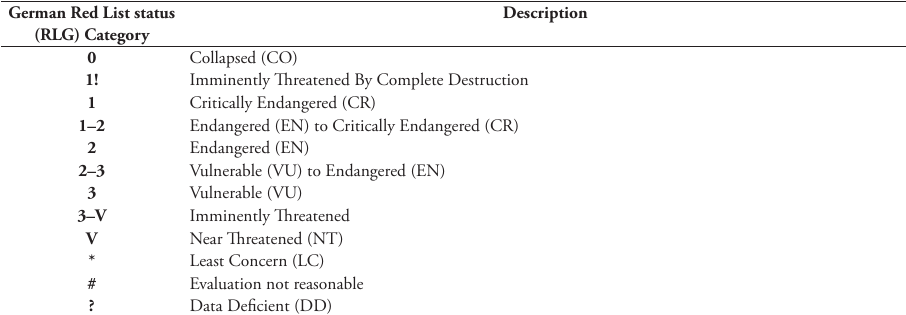
Table 4. Categories of the German Red List status (RLG). The (verbal-descriptive) definitions of the Red List categories are derived from the possible combinations of the individual criteria according to the evaluation scheme (see Table 1, 2). The categories ‘Imminently Threatened By Complete Destruction’ (1!) and ‘Imminently Threatened’ (V–3) are newly introduced. These new categories represent both extremes of ‘collapse risk’ in the German